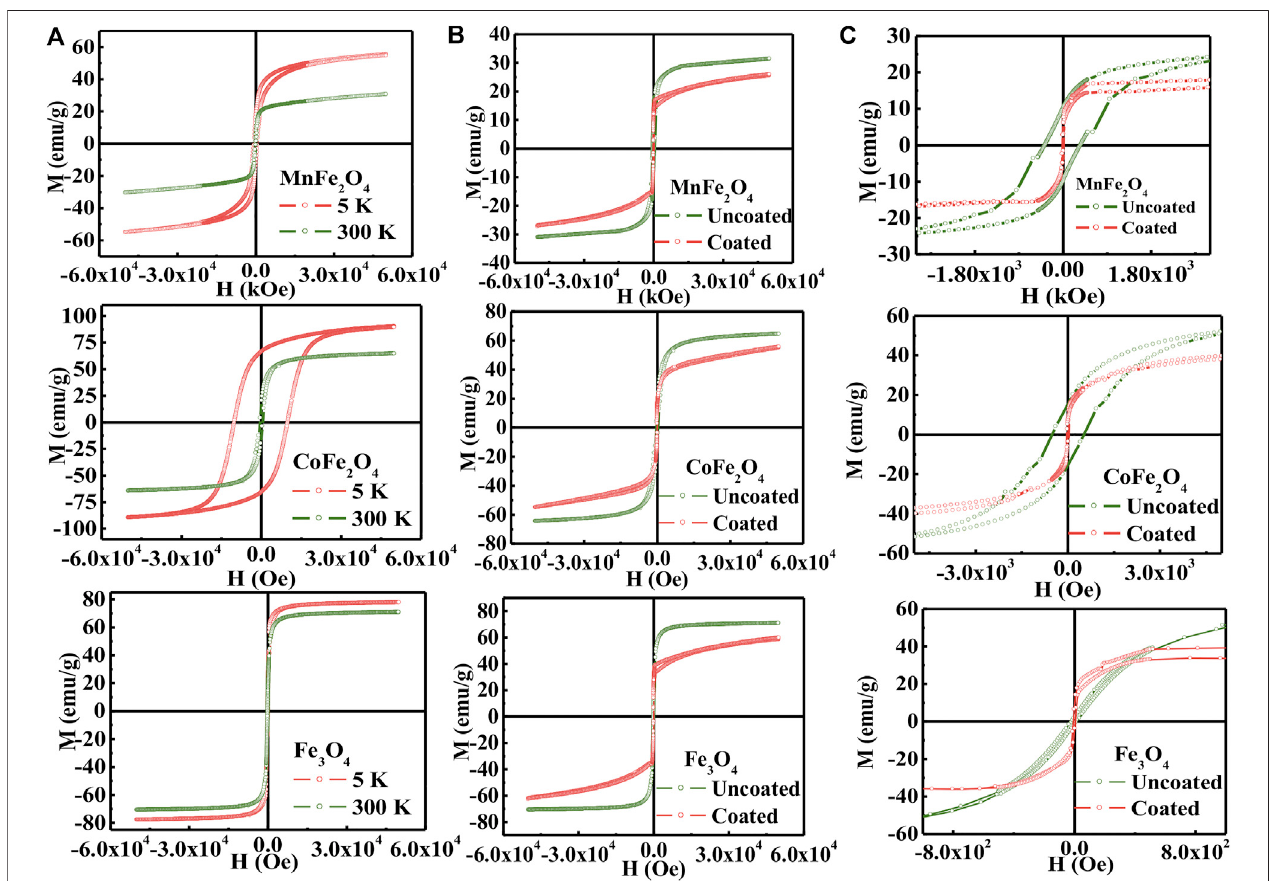
FIGURE 3 | (A) M-H hysteresis loops for the compositions of MNFe 2 O 4 , COFe 2 O 4 , and Fc 3 O 4 nanoparticles in the bare state at 5 and 300K, (B) uncoated and coated condition with chitosan and (C) The low fi eld region of H-M hysteresis loops presented in (B) .